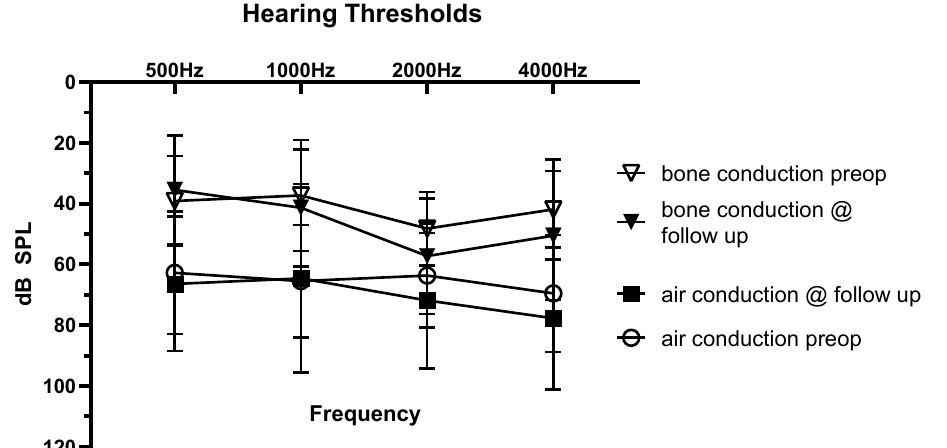
Figure 1. Pre- and postoperative AC and BC hearing thresholds in pure tone audiogram (mean and SD).